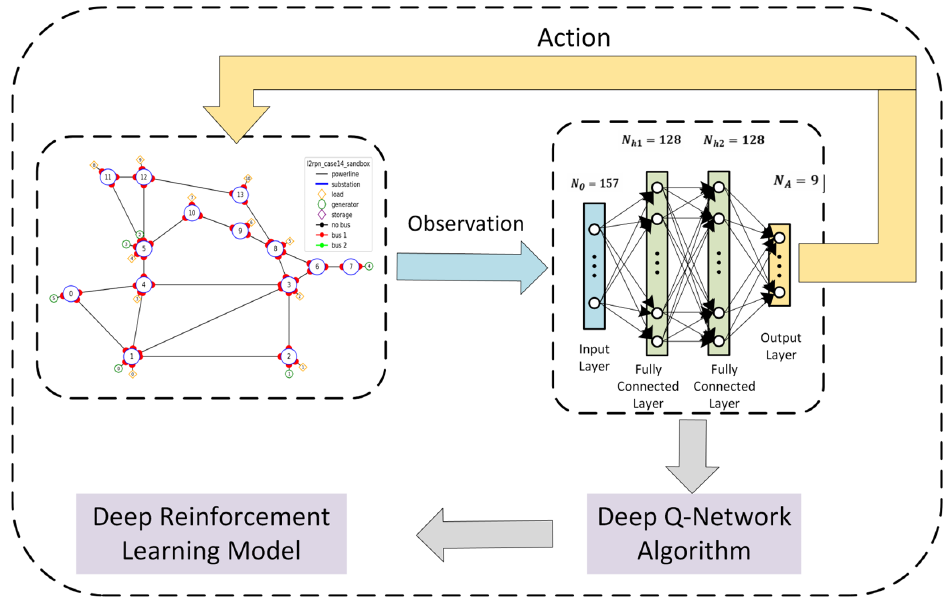
Figure 5. DQN framework.